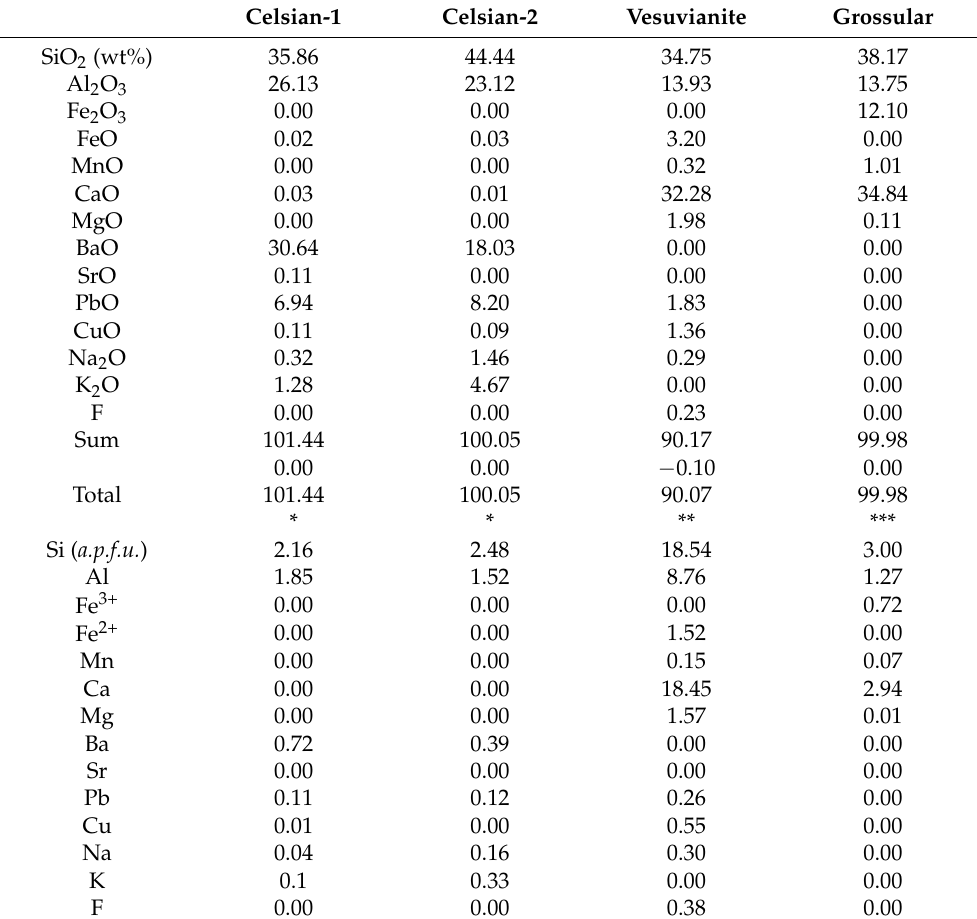
Table 2. EPMA representative analyses of phases associated with zoisite-(Pb). Celsian-1 Celsian-2